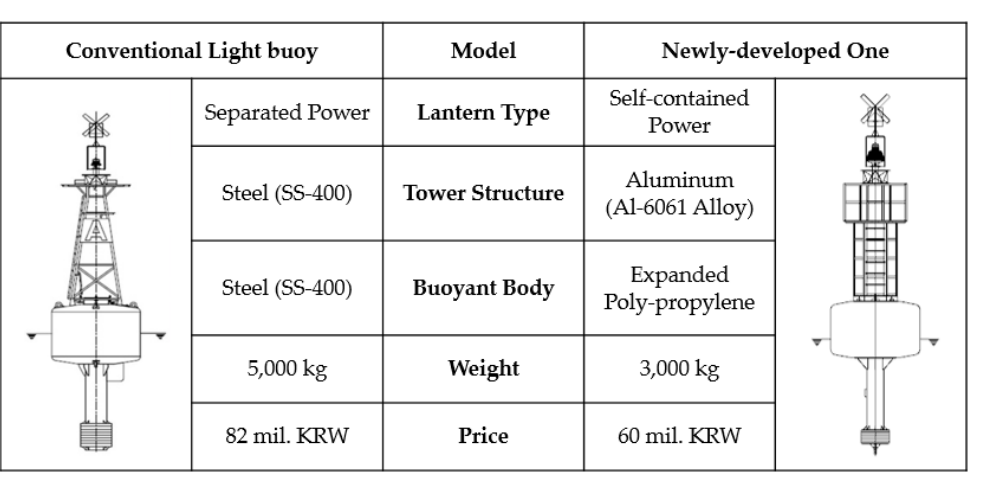
Figure 2. Comparison between a conventional light buoy and the lightweight one developed by Jeong et al. [1].